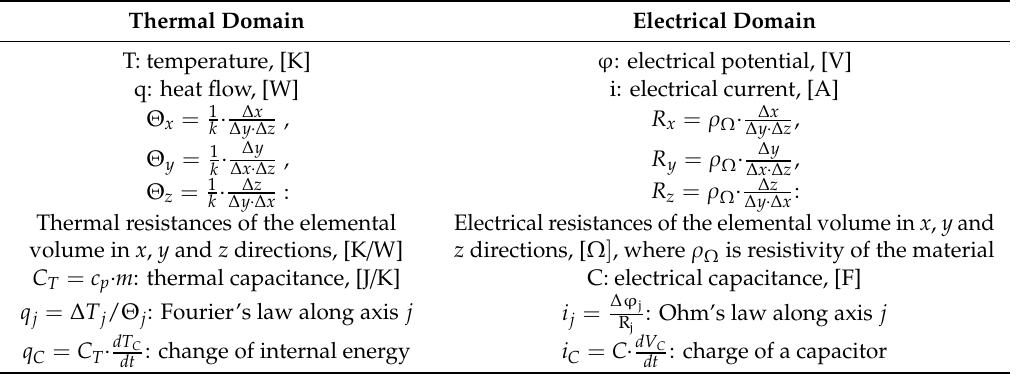
Table 1. Analogies between thermal and electrical